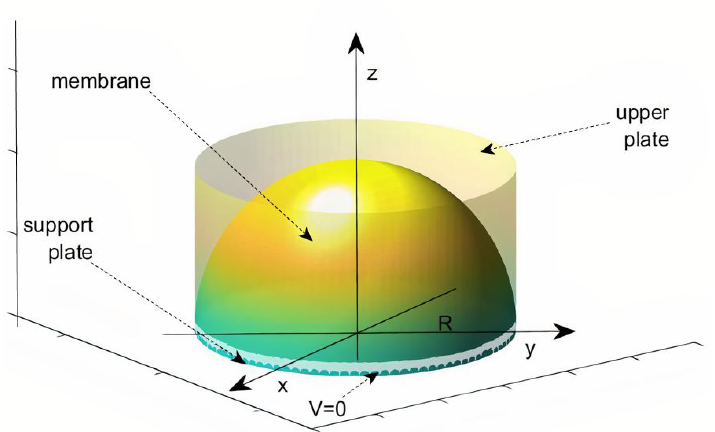
Figure 1. Simplified representation of the 2 D electrostatic circular membrane MEMS device. The membrane, anchored to the edges of the lower disk (whose potential V = 0), deforms to- wards the upper disk (whose potential is V (cid:54) = 0) without ever touching it to avoid unwanted electrostatic